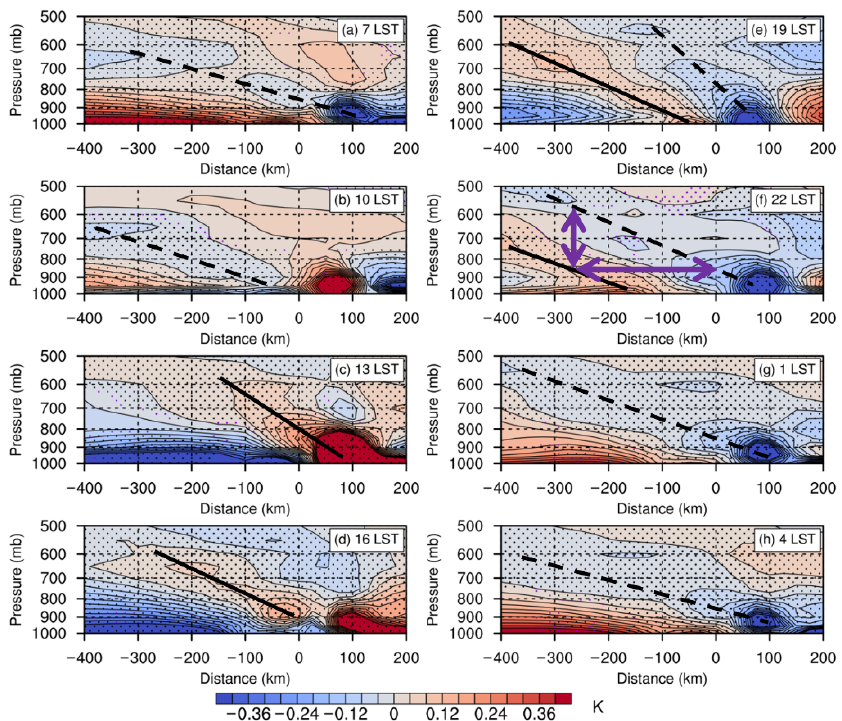
Figure 11. The temporal evolution of the vertical cross section of temperature deviations (K) as averaged at ( a ) 07 LST, ( b ) 10 LST, ( c ) 13 LST, ( d ) 16 LST, ( e ) 19 LST, ( f ) 22 LST, ( g ) 01 LST, and ( h ) 04 LST, in DJF 2011–2020. The purple and black dots indicate the 90% and 95% confidence according to the Student’s t-test.